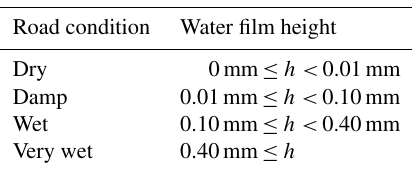
Figure 9. Integration of the sensor system into a test vehicle. (a) At- tachment of the enclosure on the backside of the front left wheel arch liner. (b) Placement of the transducer on the inside of the wheel arch liner. Table 4. Assignment of the evaluated road surface conditions and the water film height h .